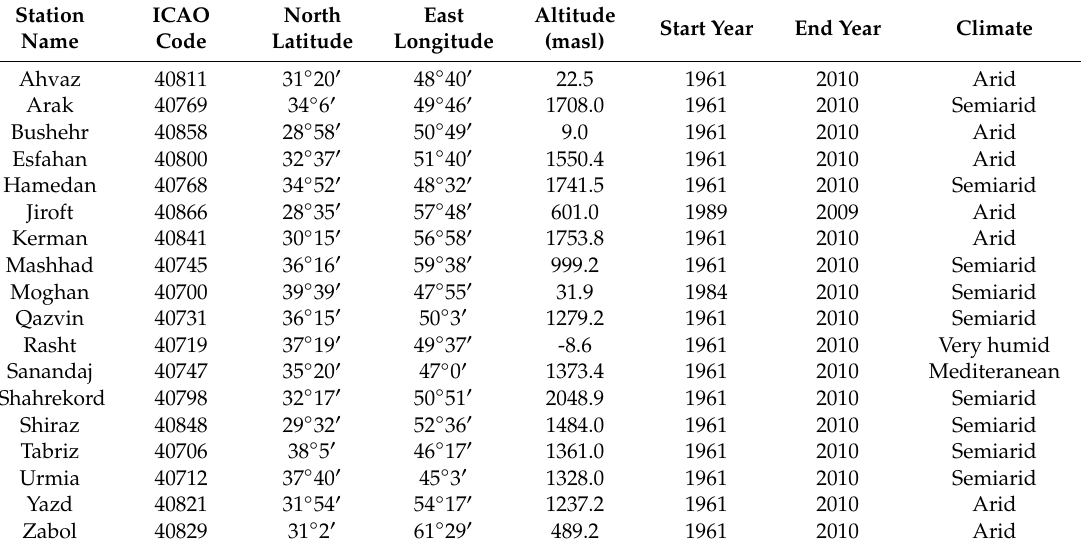
Table 4. Position and climate of the stations with length of collected